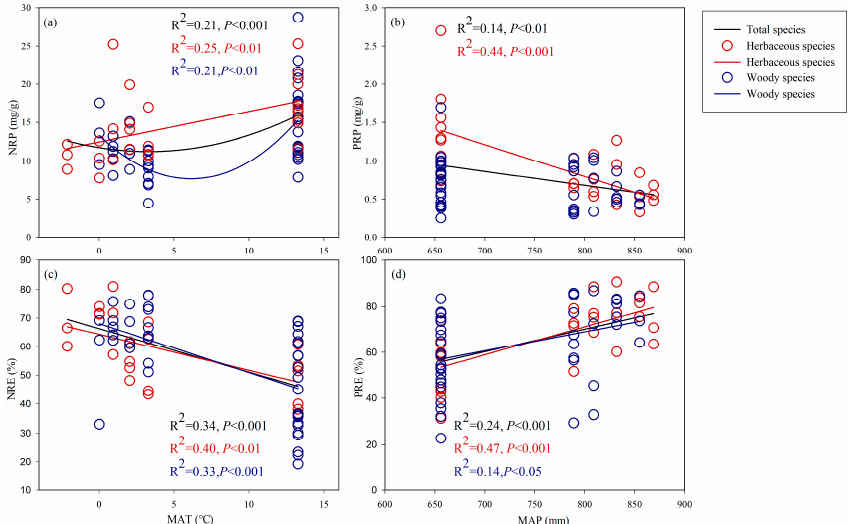
Figure 4. Regression relationships between selected climatic factors and leaf nutrient resorption traits. ( a ) Regression relationships between MAT (mean annual temperature) and NRP. ( b ) Regression relationships between MAP (mean annual precipitation) and PRP. ( c ) Regression relationships between MAT and NRE. ( d ) Regression relationships between MAP and PRE. The value of R 2 and P of all significant regressions are given.